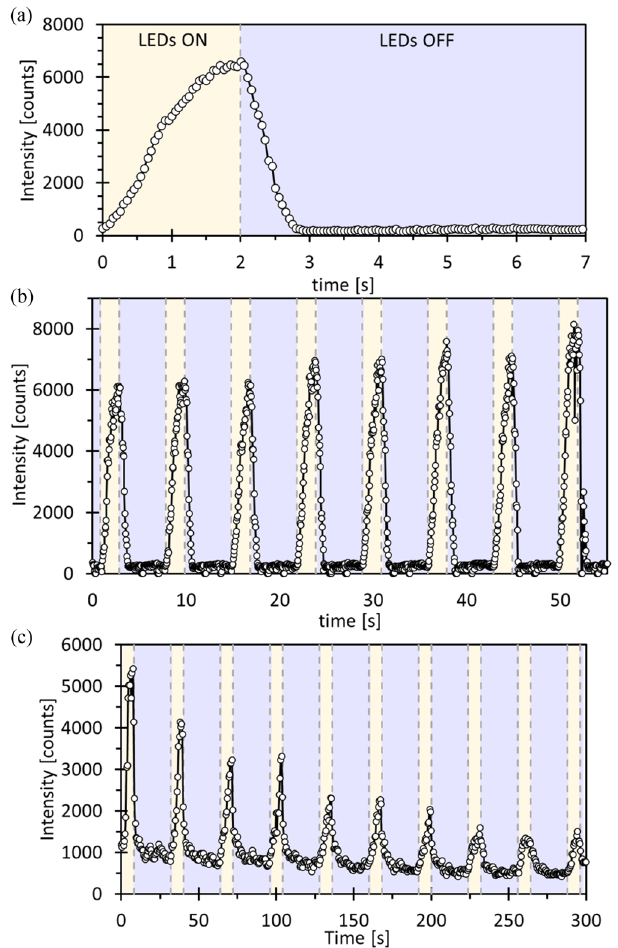
Fig. 5 Intensity of the ( − 2 1 0) re fl ection of 1 recorded using a Timepix3 detector chip. a Intensity change during one cycle with t exc = 2 s (LEDs on) and t dec = 5 s (LEDs off) at T = 286 K, averaged over eight repeats. b Intensity change over ten consecutive cycles with t exc = 2 s and t dec = 5 s at T = 286 K. c Intensity change over ten consecutive cycles with t exc = 8 s and t dec = 24 s at T = 280 K. In each case the photon events recorded by the detector are integrated into 50 ms time